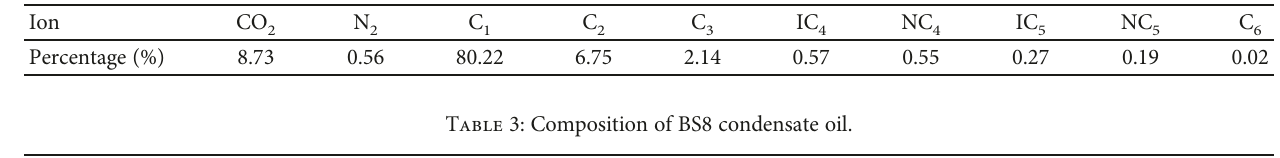
Table 2: Composition of BS8 natural gas.